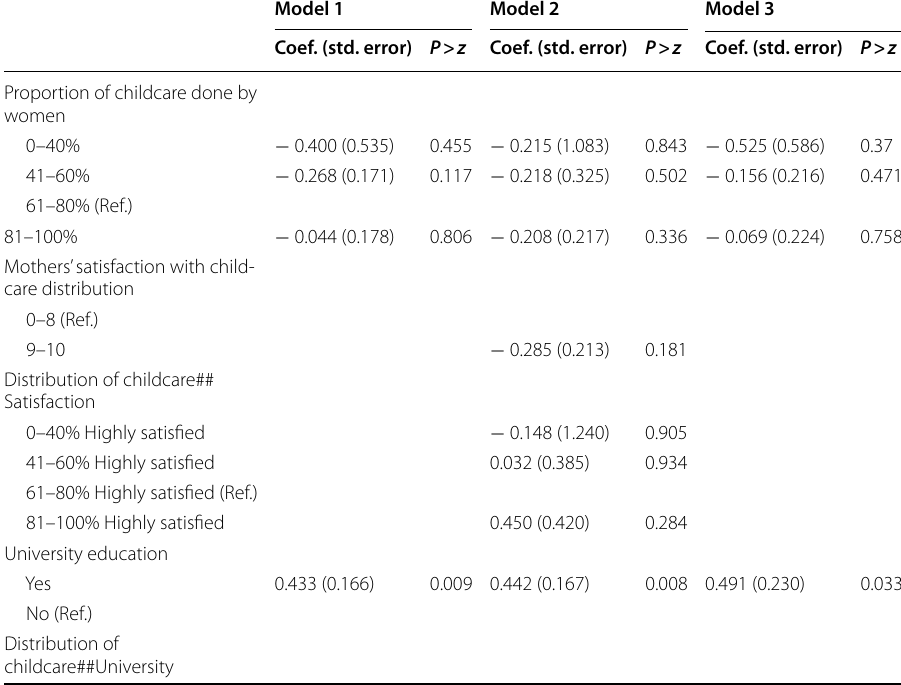
Table 3 Logit models: